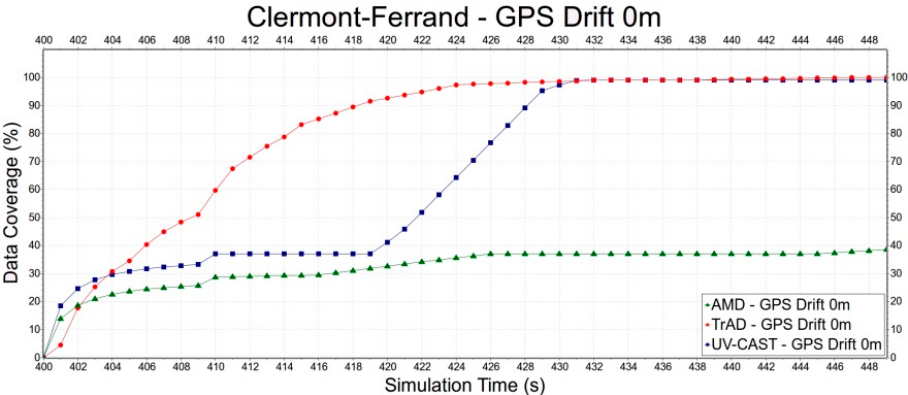
Figure 15. The data dissemination speed of TrAD, AMD and UV-CAST with perfect GPS.